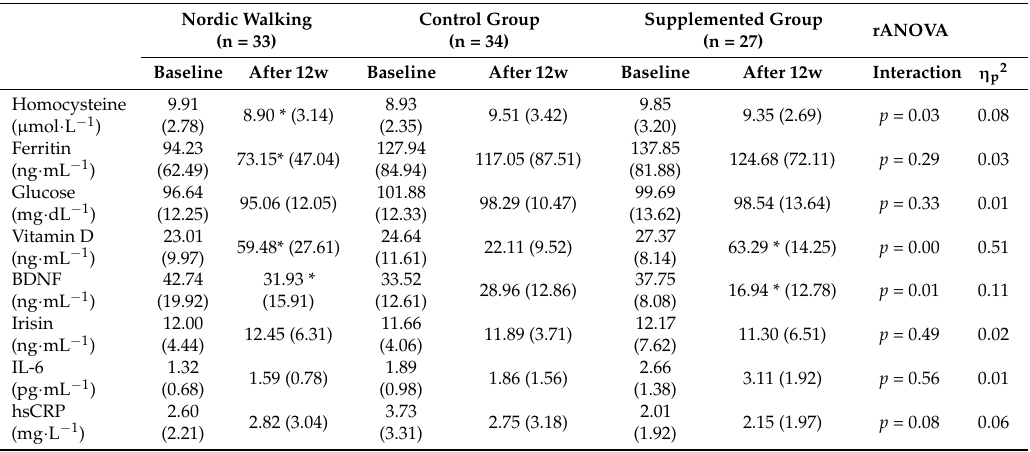
Table 3. Changes induced by the applied procedure in the NW group—training and supplementation, in SP by supplementation and values of control group